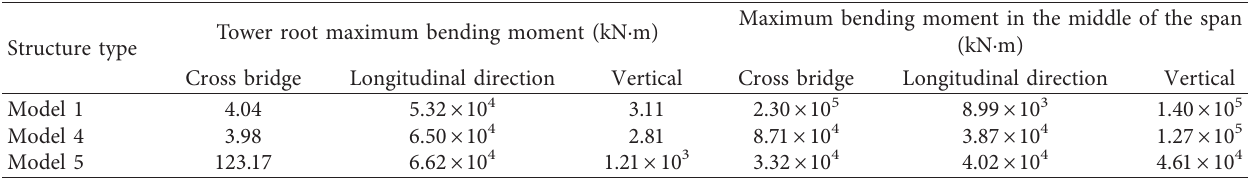
Table 9: The maximum bending moments of the tower roots and midspans of the three structural models under transverse excitation. Structure type